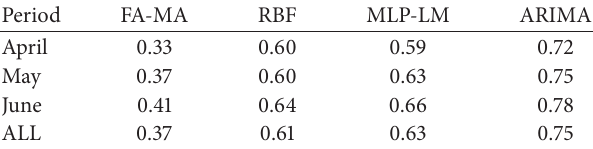
Table 8: MASE of four forecasting models.